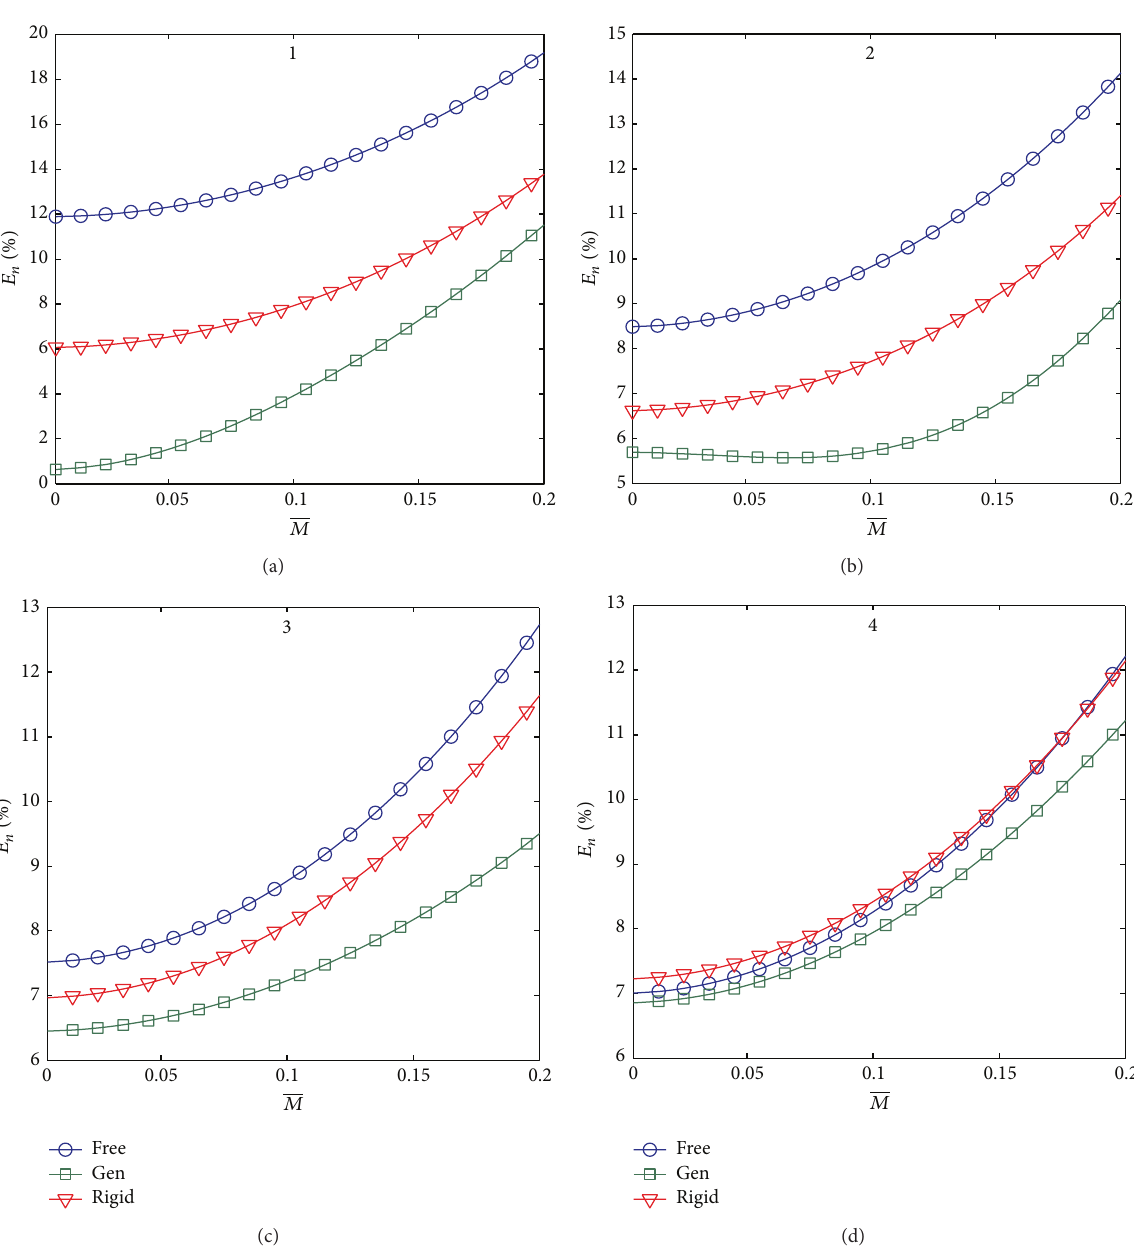
Figure 10: (Color online) Comparison of the measurement errors of the first four axial modes among the three different boundary configurations in the turbulent flow. See Figure 2 for legend